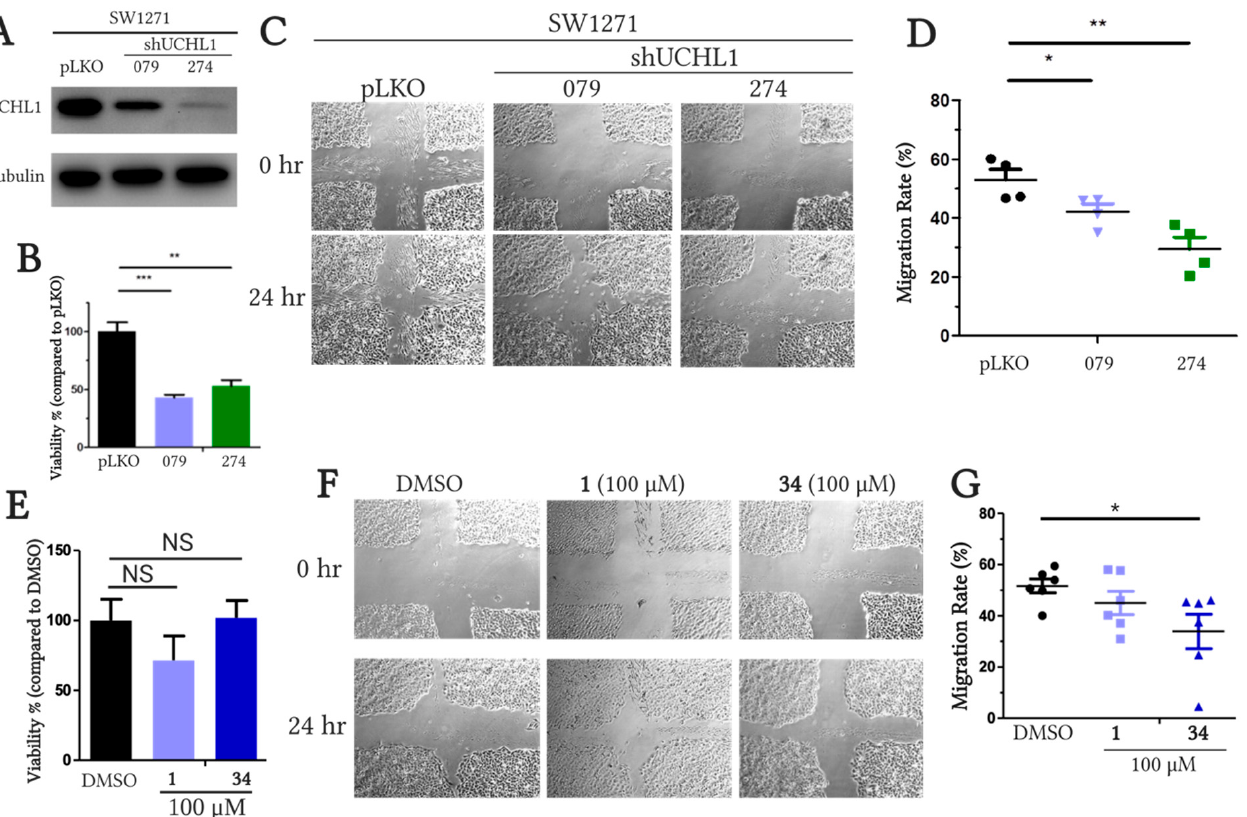
Figure 9. Effect of UCHL1 on migration of SW1271 cells. ( A ) Knockdown of UCHL1 in SW1271 cells. Shown are vector control (pLKO) and shRNA 079 and 274. ( B ) Effect of shRNA knockdown on SW1271 cell viability compared to pLKO control. ( C ) Wound healing cell images on SW1271 pLKO and UCHL1 knockdown cells at 0- and 24-h time points. Representative replicates shown for each. ( D ) Migration rate in % area covered by cells in 24-h period compared to pLKO control. ( E ) Effect of compounds 1 and 34 on cell viability at 100 µM dose compared to vehicle control (DMSO). ( F ) Wound healing cell images of wild type SW1271 cells treated with fluoromethylketone inhibitors at 0 and 24-h time points. Representative replicates shown. ( G ) Migration rate in % area covered by cells in 24-h period after treatment with inhibitor. N = 6, * P < 0.05; **, P < 0.01, *** P < 0.001. NS = not significant. Statistical significance calculated using two-tailed t -test.